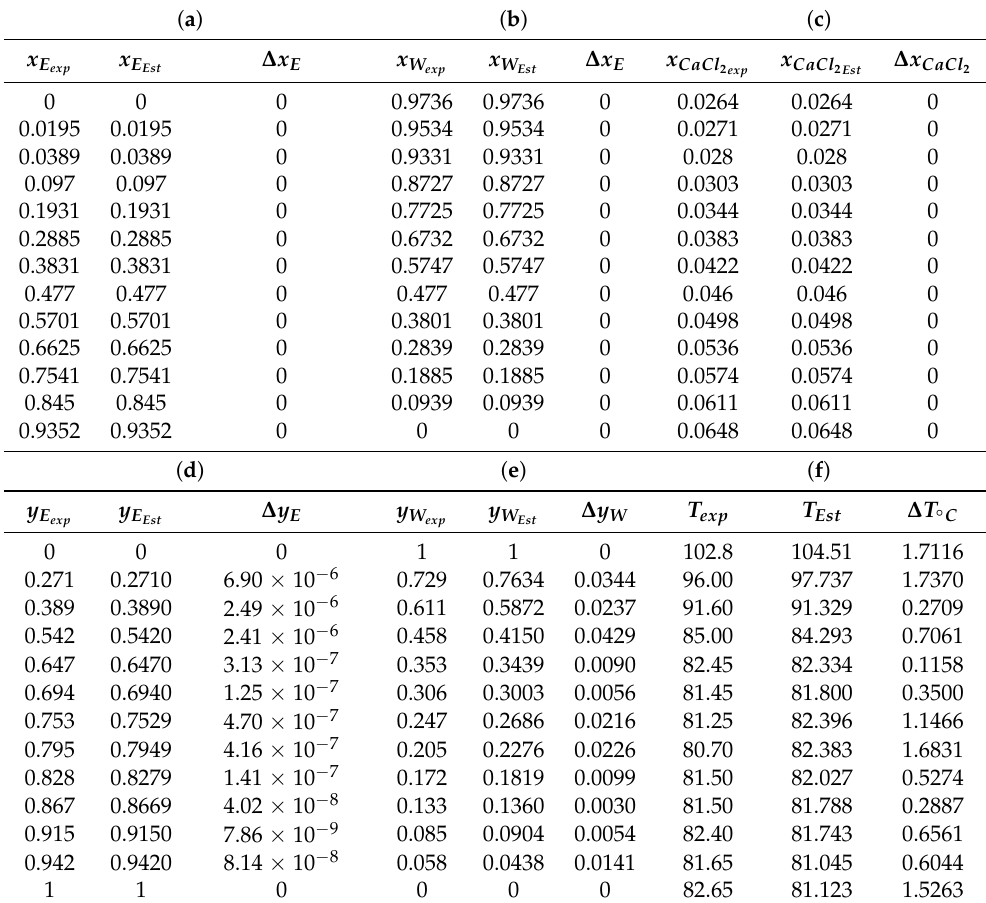
Table 2. VLE data estimated from experimental data of the ethanol − water − CaCl 2 system at 1 atm pressure and 16.7 wt% of CaCl 2 . Liquid phase apparent mole fractions: ( a ) ethanol; ( b ) water;